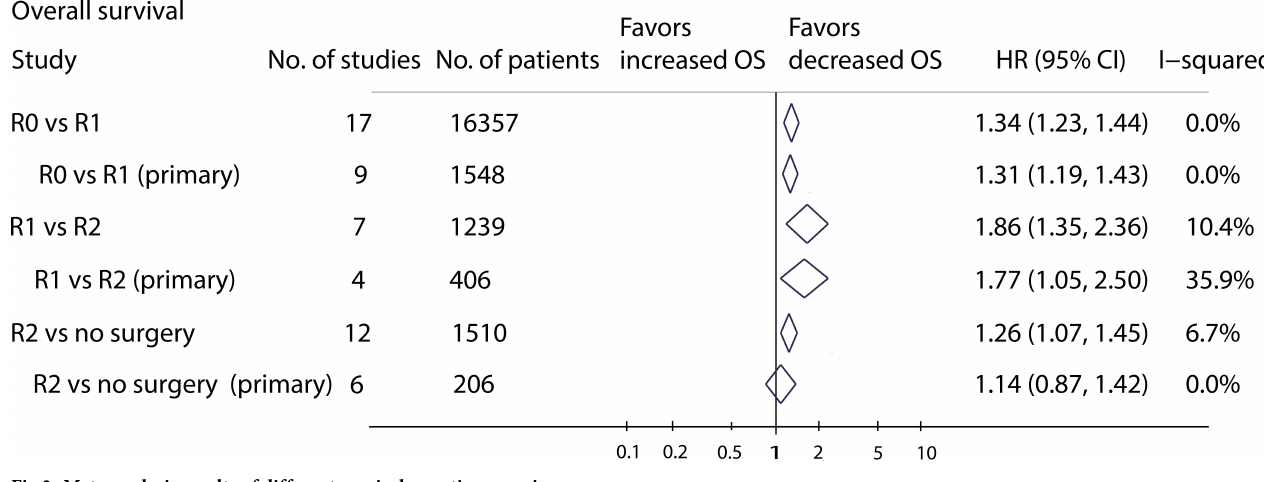
Fig 3. Meta-analysis results of different surgical resection